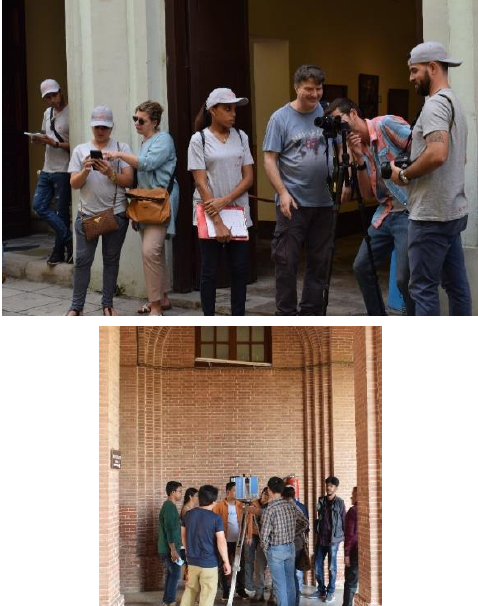
Figure 6. Points cloud in the area of S. Maria della Libera Church (D'Urso et al.,